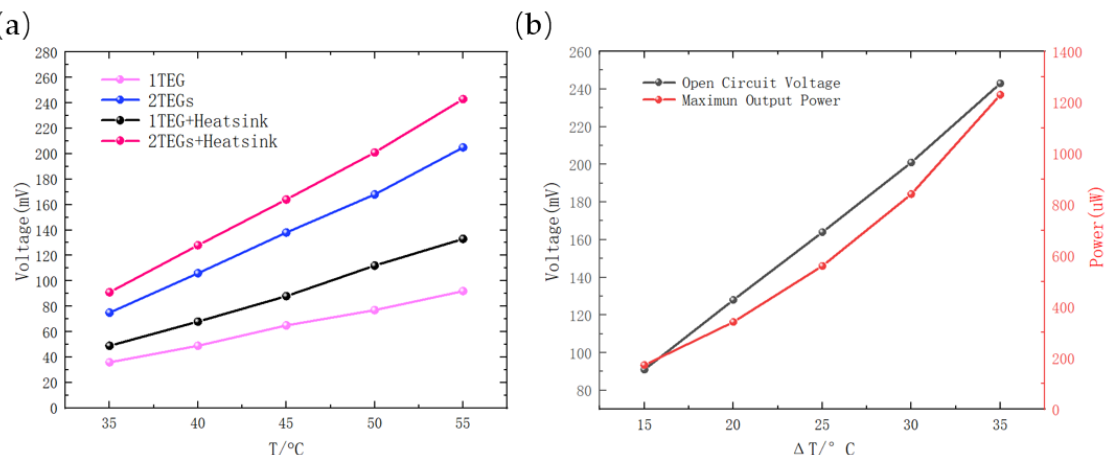
Figure 13. ( a ) Changes in open-circuit voltage with temperature gradient for different configurations of the TEG device; ( b ) performance of the TEG device comprising two vertically stacked TEGs and a heatsink.